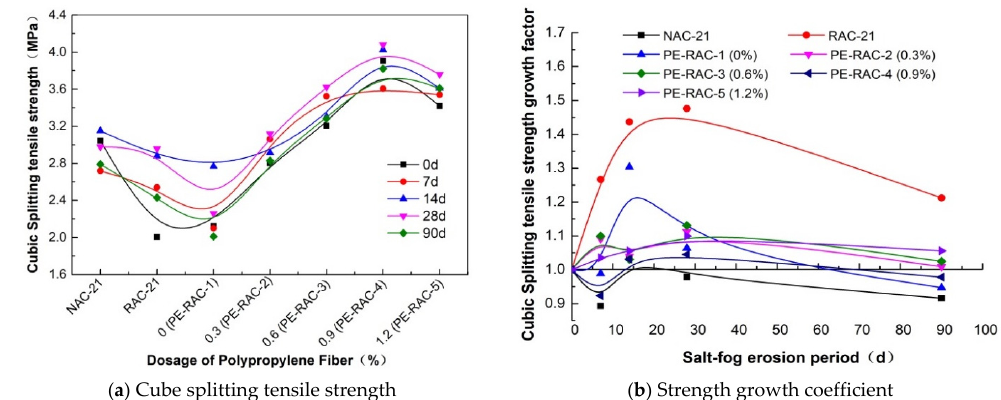
Figure 3. Influence of waste fiber content on splitting tensile strength of cube.